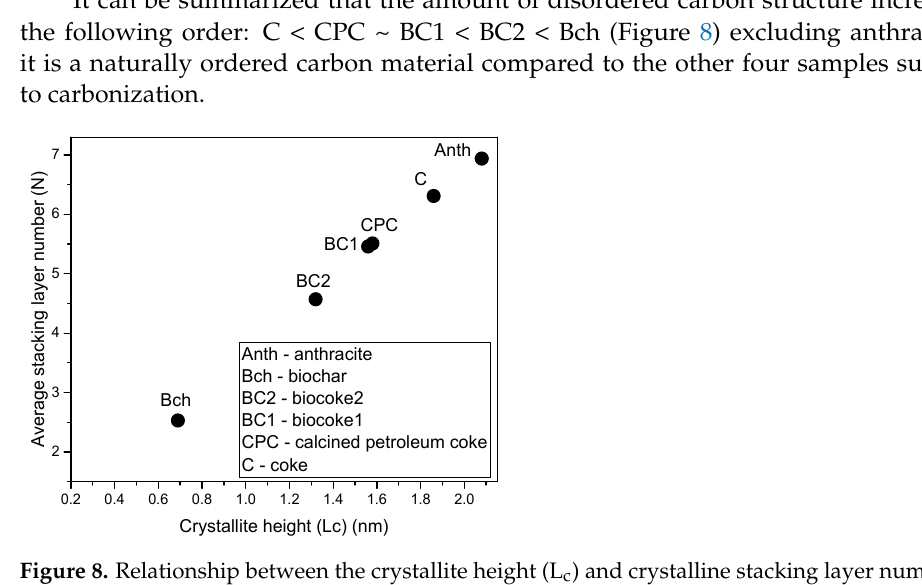
Figure 9. Relationship between the parameters of crystallite height (L c ) and selected Raman param- eters. ( a ) Relationship between crystallite height (L c ) and D-STA (mean). ( b ) Relationship between crystallite height (L c ) and the Dmax/Gmax ratio (mean).